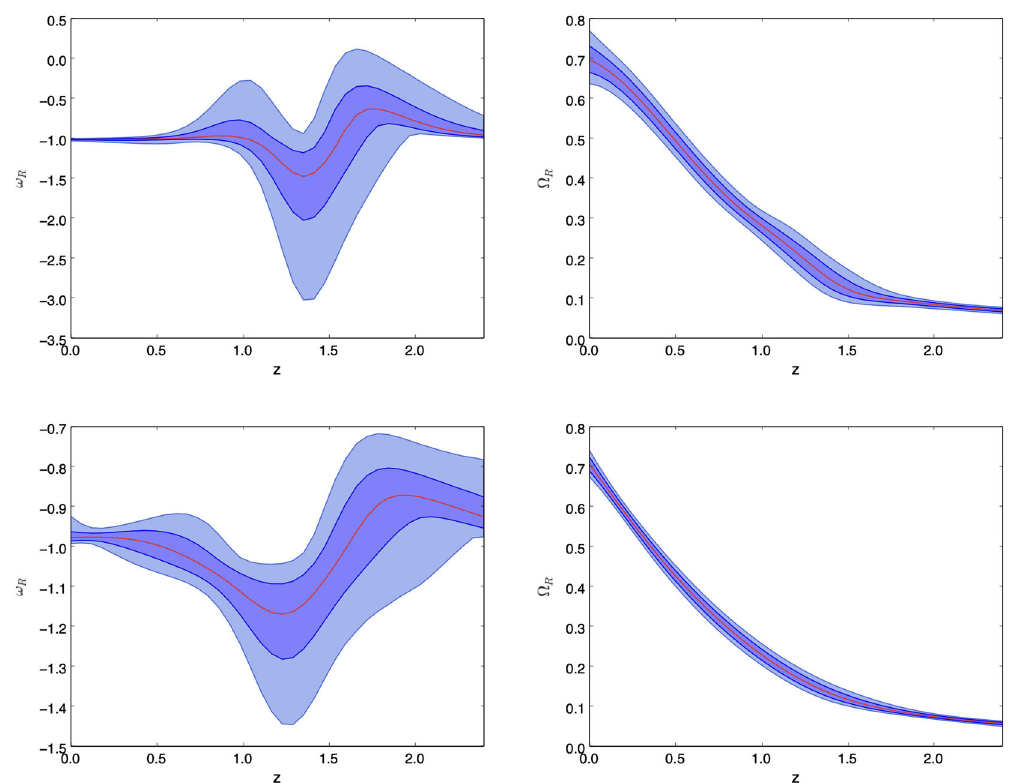
Fig. 11 The GP reconstruction of ω R and (cid:13) R for the 30 H ( z ) samples deduced from the differential age method with 10 additional samples obtainedfromtheradialBAOmethod(Table1)ispresentedontheupper panel, when H 0 = 73 . 52 ± 1 . 62 km s − 1 Mpc − 1 has been merged to the expansion rate data used in the GP. The bottom panel represents the GP reconstruction of ω R and (cid:13) R , when H 0 = 67 . 40 ± 0 . 5 km s − 1 Mpc − 1 has been merged to the expansion rate data used in the GP. The obtained reconstruction is for the f ( R ) model given by Eq. (26). The solid line